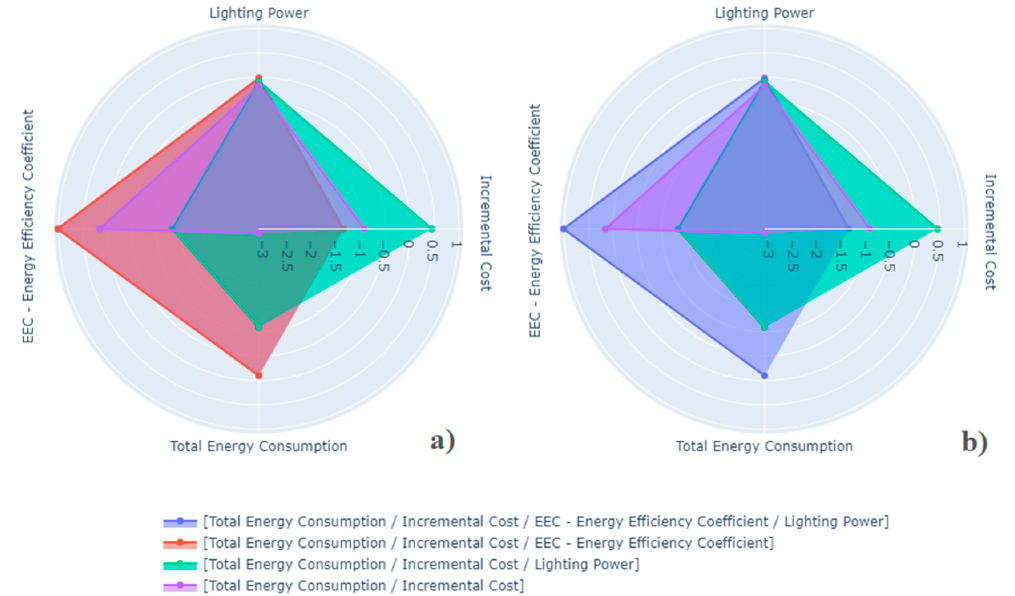
Figure 6. Best individual among all tests performed per case with “baits” ( a ) showing all 4 cases together and ( b ) without Case 2, the red.